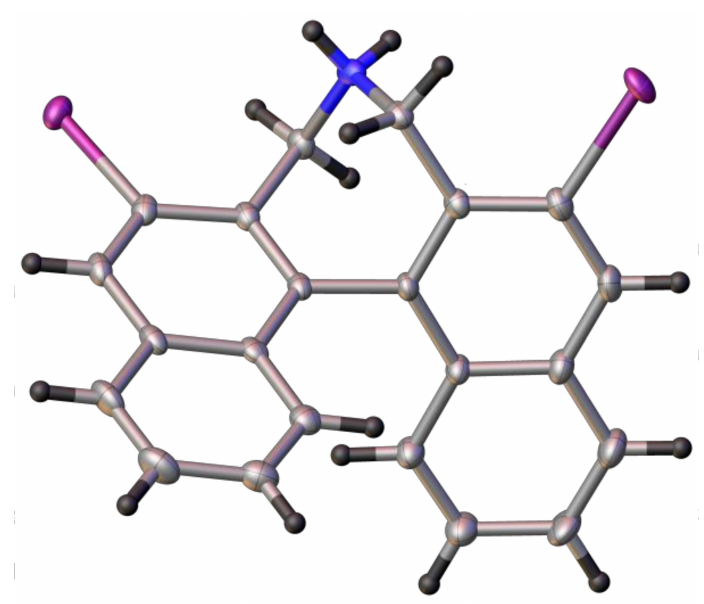
Figure 3. X-ray structure of 8 · HBr (counterion and solvent molecules ommitted).